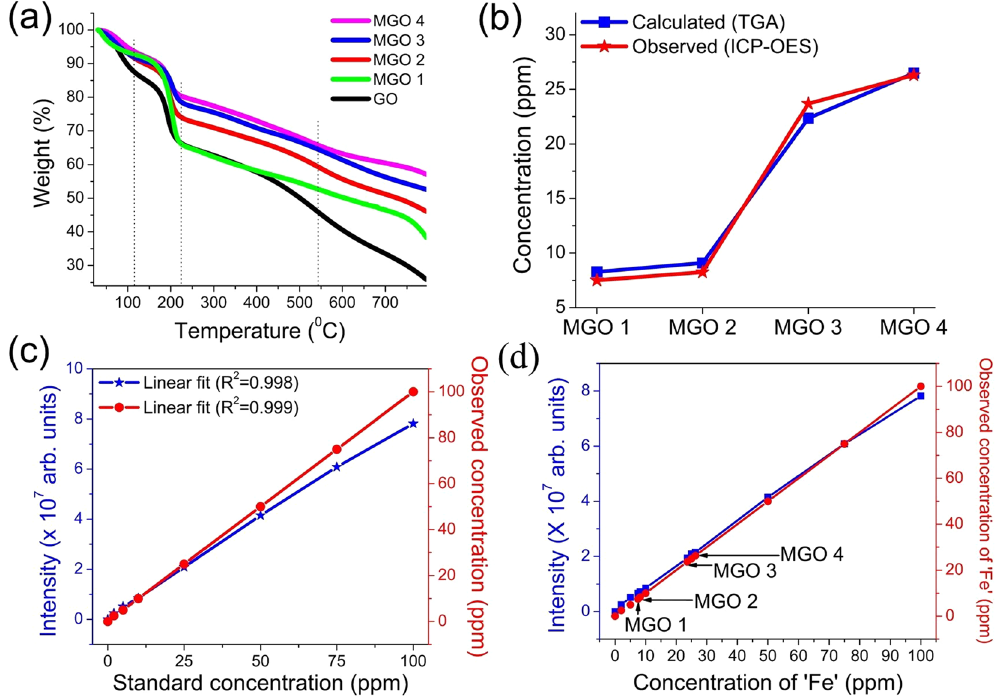
Figure 1. ( a ) Thermogravimetric analysis (TGA) profile. ( b ) A plot of calculated iron (‘Fe’) concentrations from TGA and observed from inductively coupled plasma optical emission spectrometry (ICP-OES). ( c ) The calibration linear fit of the standard solutions from ICP-OES. ( d ) Intensity and concentration plot obtained from